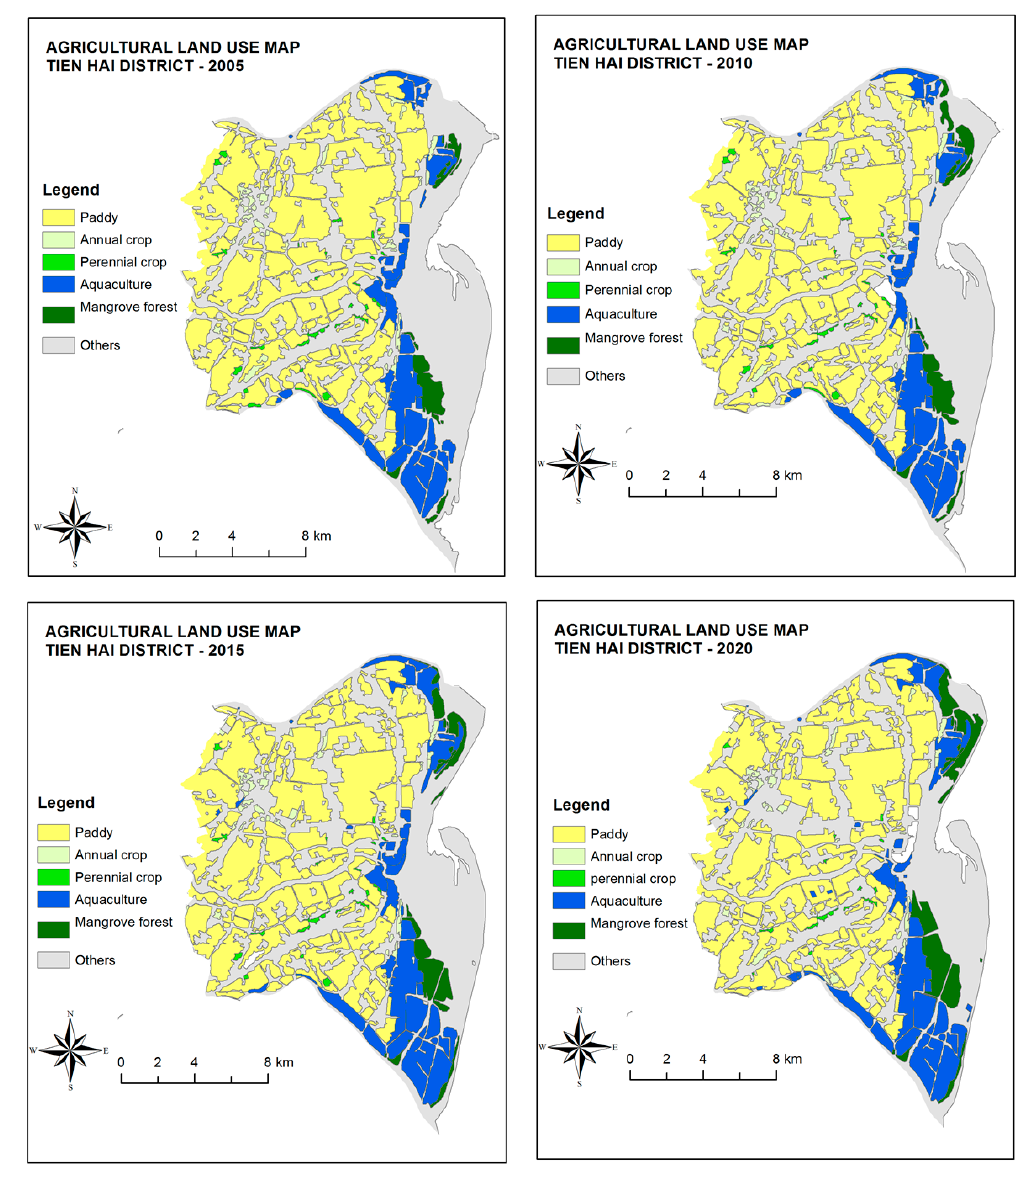
Figure 2. Land-use classification of Tien Hai district in 2005, 2010, 2015, and 2020. Table 3. Accuracy assessment of satellite image